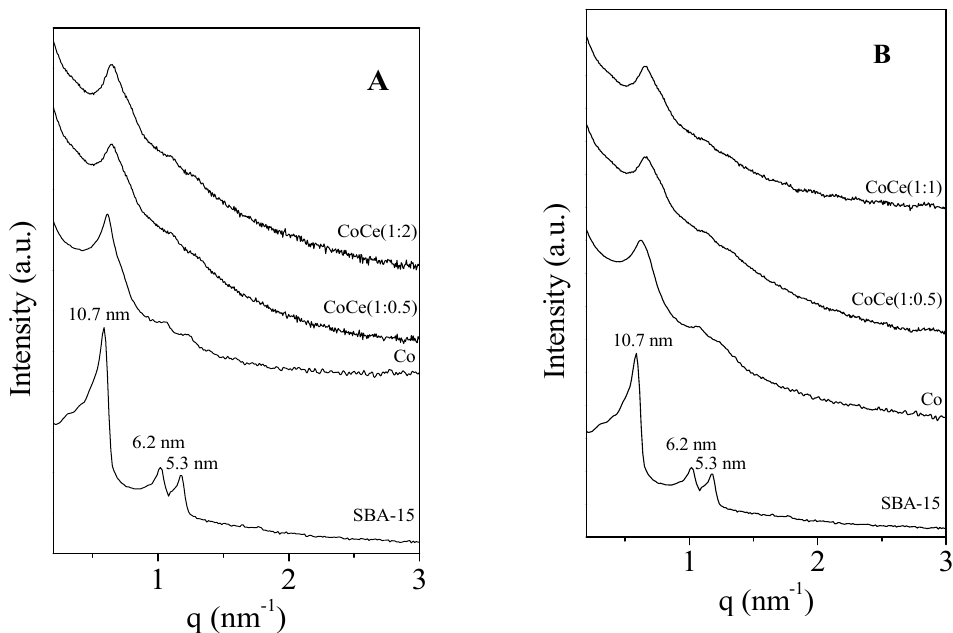
Figure 1. Small angle X-Ray scattering (SAXS) patterns of the catalysts before ( A ) and after ( B ) n-hexane oxidation.